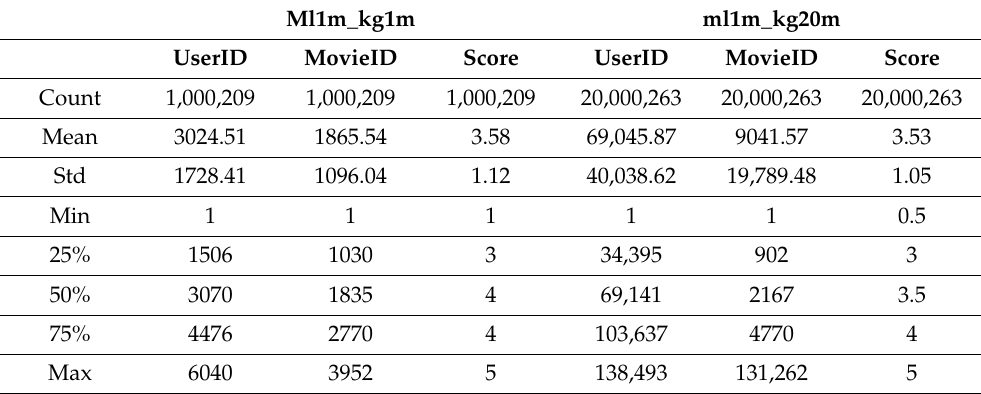
Table 1. Basic statistics of the